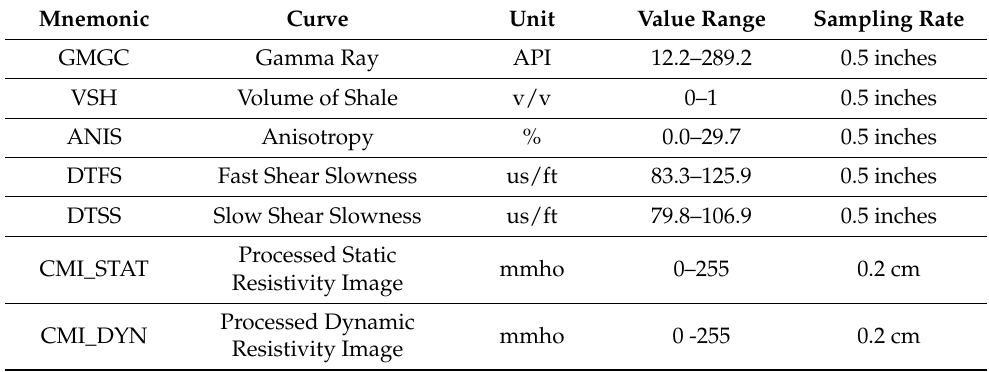
Table 1. Description of well log data used in the